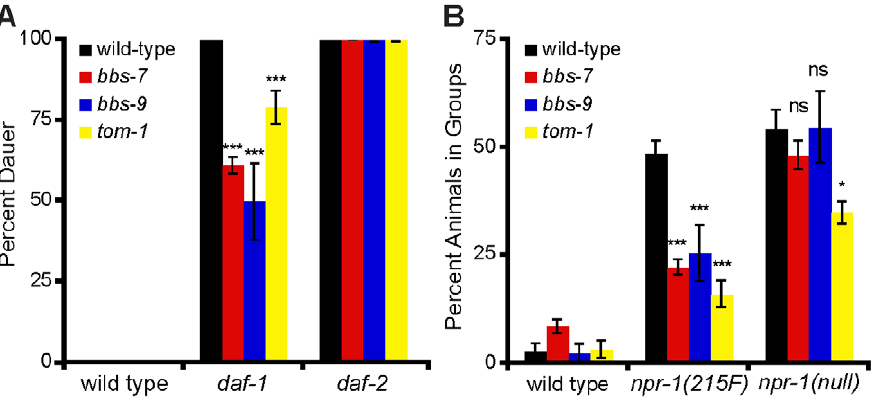
Figure 2. BBSome mutants exhibit increased insulin and neuropeptide signaling. (A) BBSome and tom-1 mutants partially suppress the dauer arrest of TG- b receptor daf-1 , but not the insulin receptor, daf-2 mutants. The percentage of dauers is shown along with standard error of the mean (*** p , 0.001 compare to daf-1 animals). (B) BBSome and tom-1 mutants partially suppress the hypomorphic (215F) allele but not the null allele of the NPY-like receptor npr-1 . Percentage of animals feeding in social groups is shown with standard error (*** p , 0.001, * p , 0.05; ns , not significant, comparing double mutants with the corresponding npr-1 single mutant).